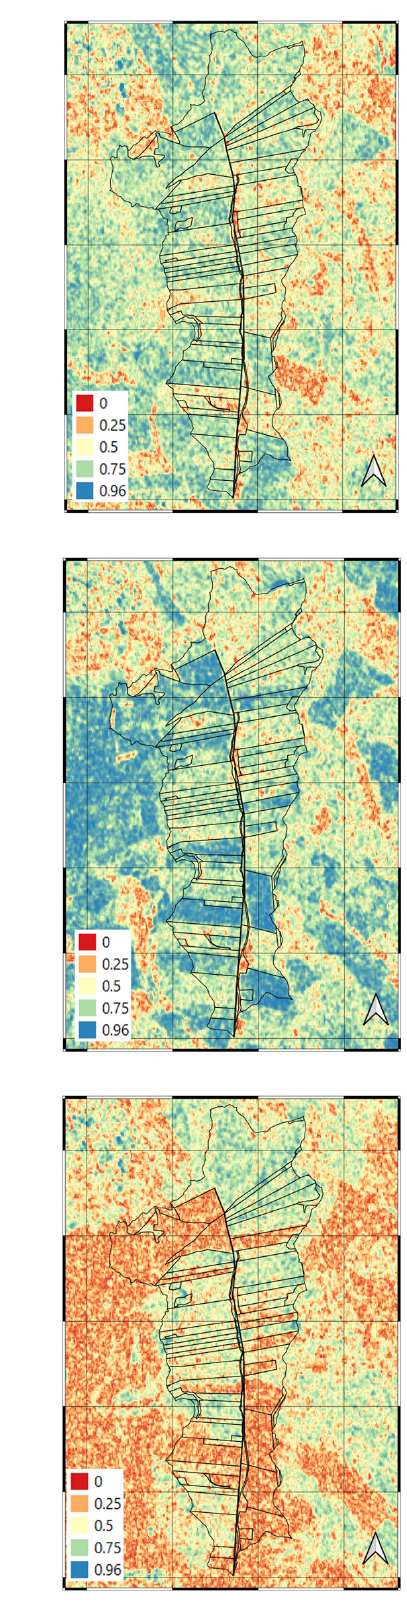
Figure 6. Coherence raster between acquisitions in scenarios AW-1, AW-2 and AW-3. The histogram shows only values of the part of the raster inside the basin. Zebra frame segments of 1 km.